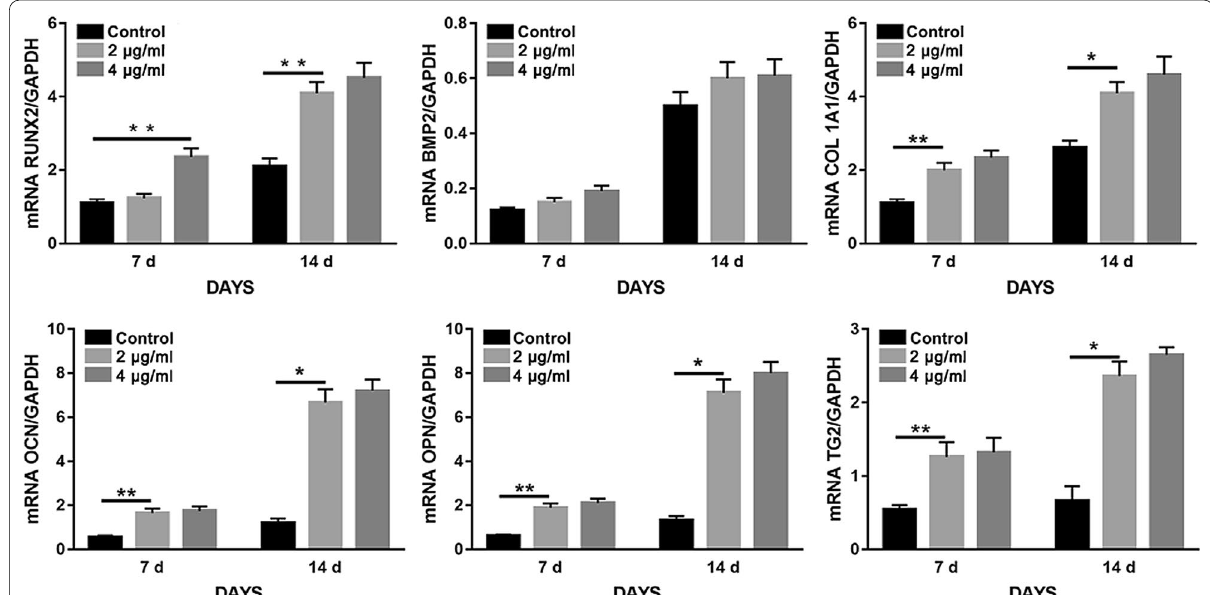
Fig. 6 BPs potentiates osteogenesis of EMSCs. EMSCs were grown in osteogenic medium with 0 μg/ml, 2 μg/ml, 4 μg/ml BPs 14 days. Expression of genes involved in osteogenesis of EMSCs was quantified by quantitative reverse transcriptase polymerase chain reaction (RT-qPCR). ** p < 0.01, * p < 0.05.